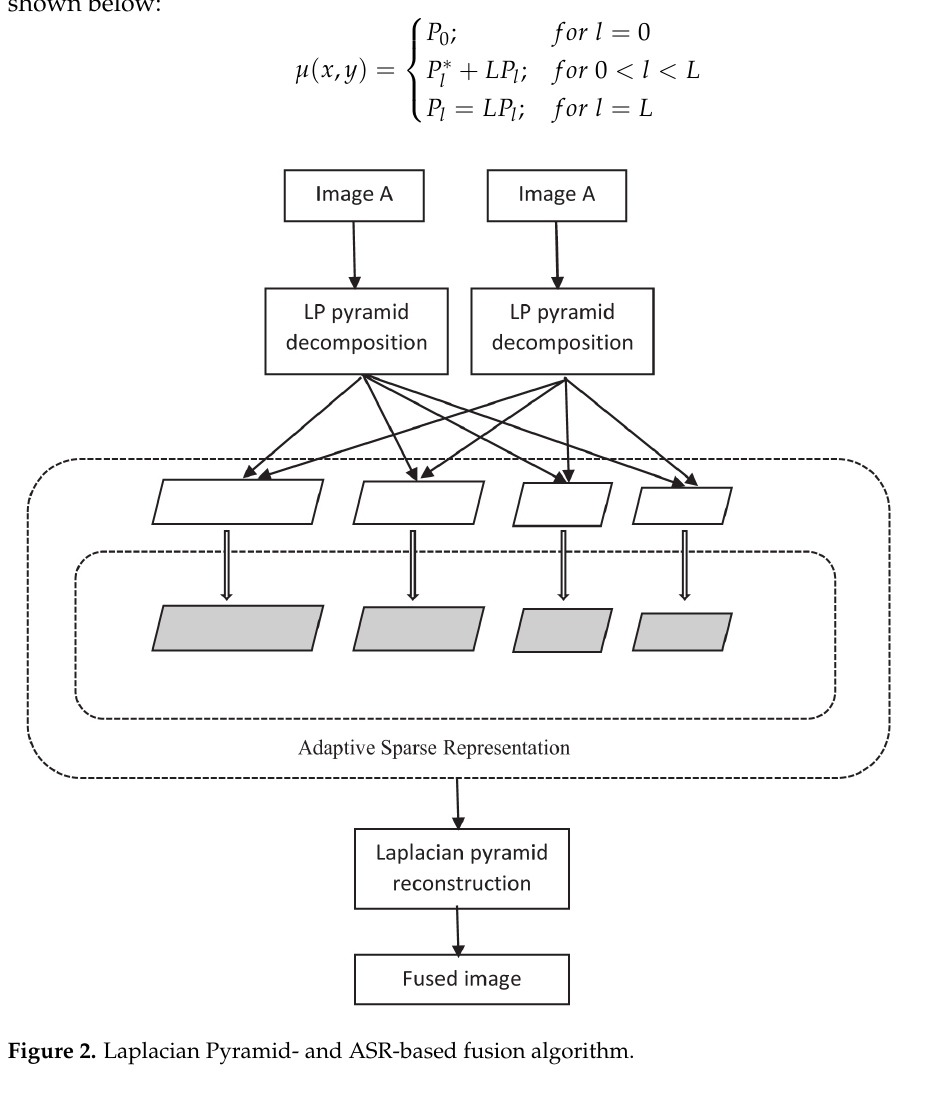
Figure 2. Laplacian Pyramid- and ASR-based fusion algorithm.